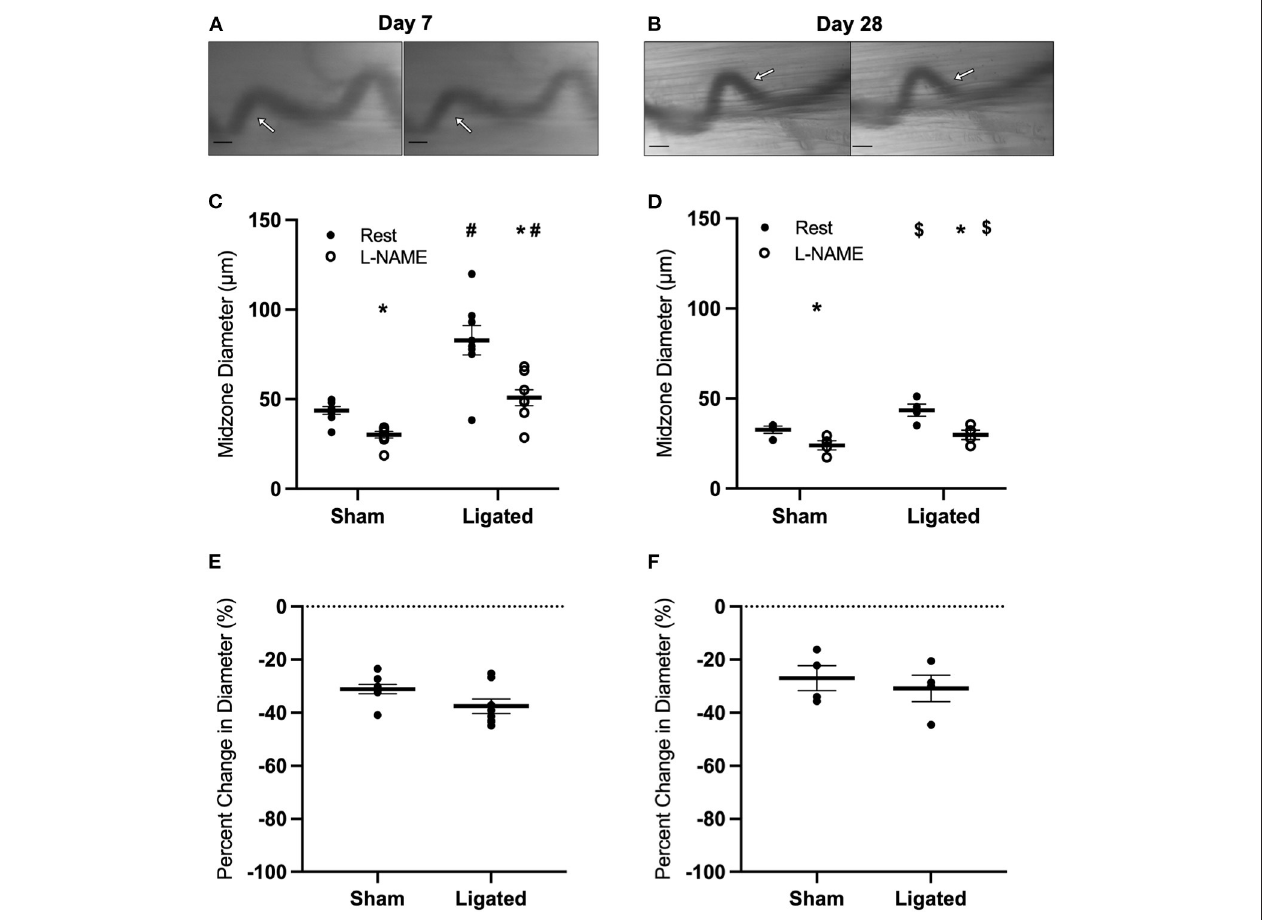
FIGURE 3 | Collateral vessels are not more sensitive to nitric oxide inhibition at day 7 and day 28. Collateral vessels were observed at the collateral midzone by intravital microscopy with transillumination at 7 days (A) or 28 days (B) post-femoral artery ligation in the left mouse hindlimb at rest (left) and following exposure to 10 − 4 M of nitric oxide inhibitor L-NAME (right); arrows indicate the enlarged collateral arteriole and scale bar represents 100 µ m. Nitric oxide inhibition vasoconstricts collaterals at both day 7 ( C , n = 8) and day 28 ( D , n = 4). However, there is no difference in the vascular reactivity between the native and enlarged collaterals at both 7 days (E) or 28 days (F) post-femoral artery ligation. * p < 0.05 vs. resting, # p < 0.05 vs. sham, $ p < 0.05 vs. day